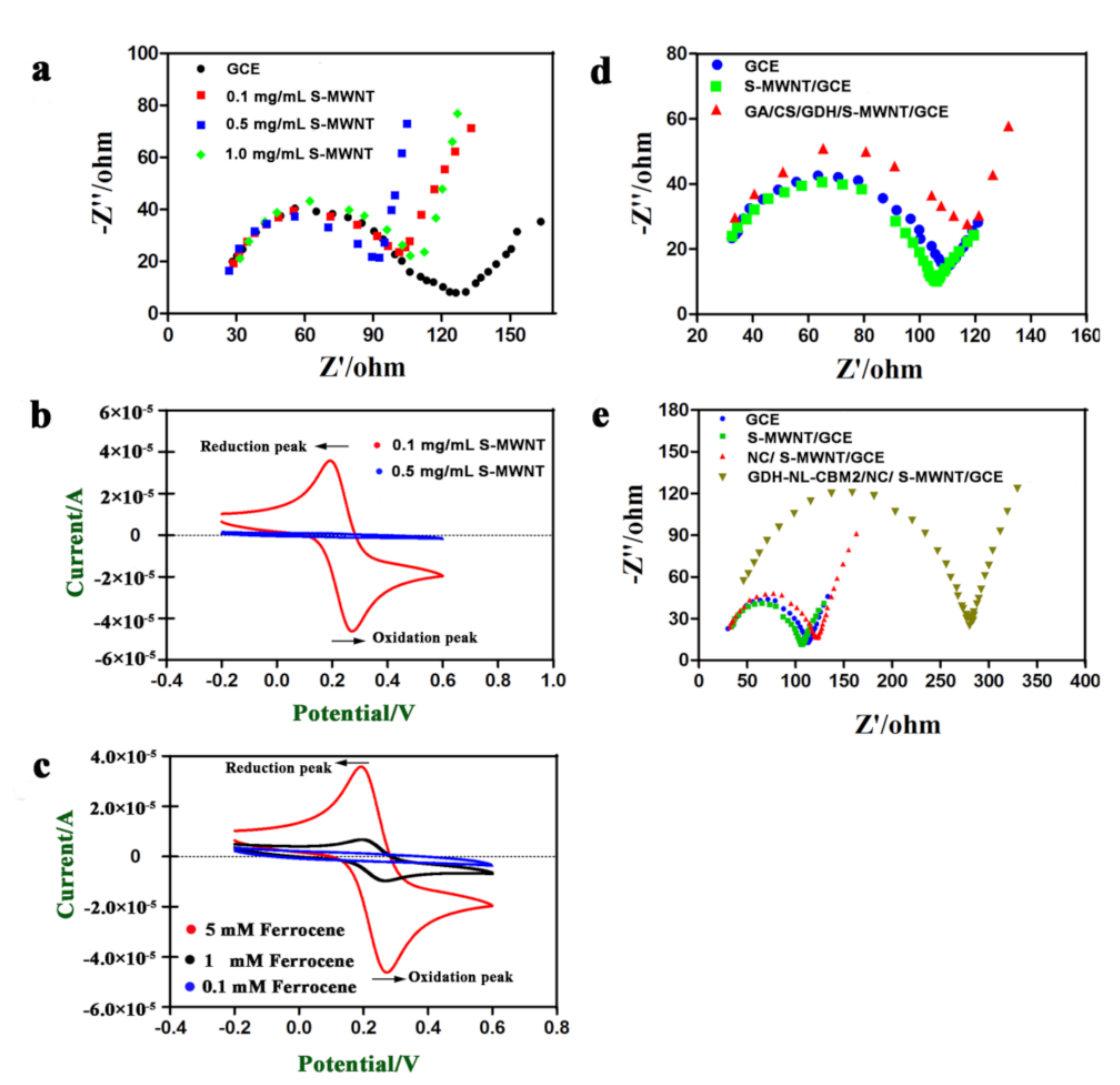
Figure 4. Electrochemical characterization of the electrodes prepared by two different methods . ( a ) Impedance spectra for bare GCE (black), 0.1 mg/mL S-MWCN/GCE (red), 0.5 mg/mL S-MWCN/GCE (blue), and 1 mg/mL S-MWCN/GCE (green) electrode; ( b ) CV of GCE modified with 0.1 mg/mL (red) and 0.5 mg/mL (blue) S-MWNT in 5 mmol/L fer- rocene (Fc) solution; ( c ) CV of GCE modified with 0.1 mg/mL S-MWNT in 0.1 mmol/L (blue), 1 mmol/L (black) and 5 mmol/L (red) ferrocene solution; ( d ) Impedance spectra for bare GCE (blue), S-MWCN/GCE (green), and GA/CS/GDH/S- MWCN/GCE (red); ( e ) Impedance spectra of bare GCE (blue), S-MWCN/GCE (green), NC/S-MWNT/GCE (red), and GDH-NL-CBM2/NC/S-MWNT/GCE (brown). The measurement of EIS was performed in a 0.1 M KCl solution contain- ing 10 mM K 3 [Fe(CN) 6 ] and K 4 [Fe(CN) 6 ] as the electrochemical probe solution. The arrows in b and c indicated the scanning